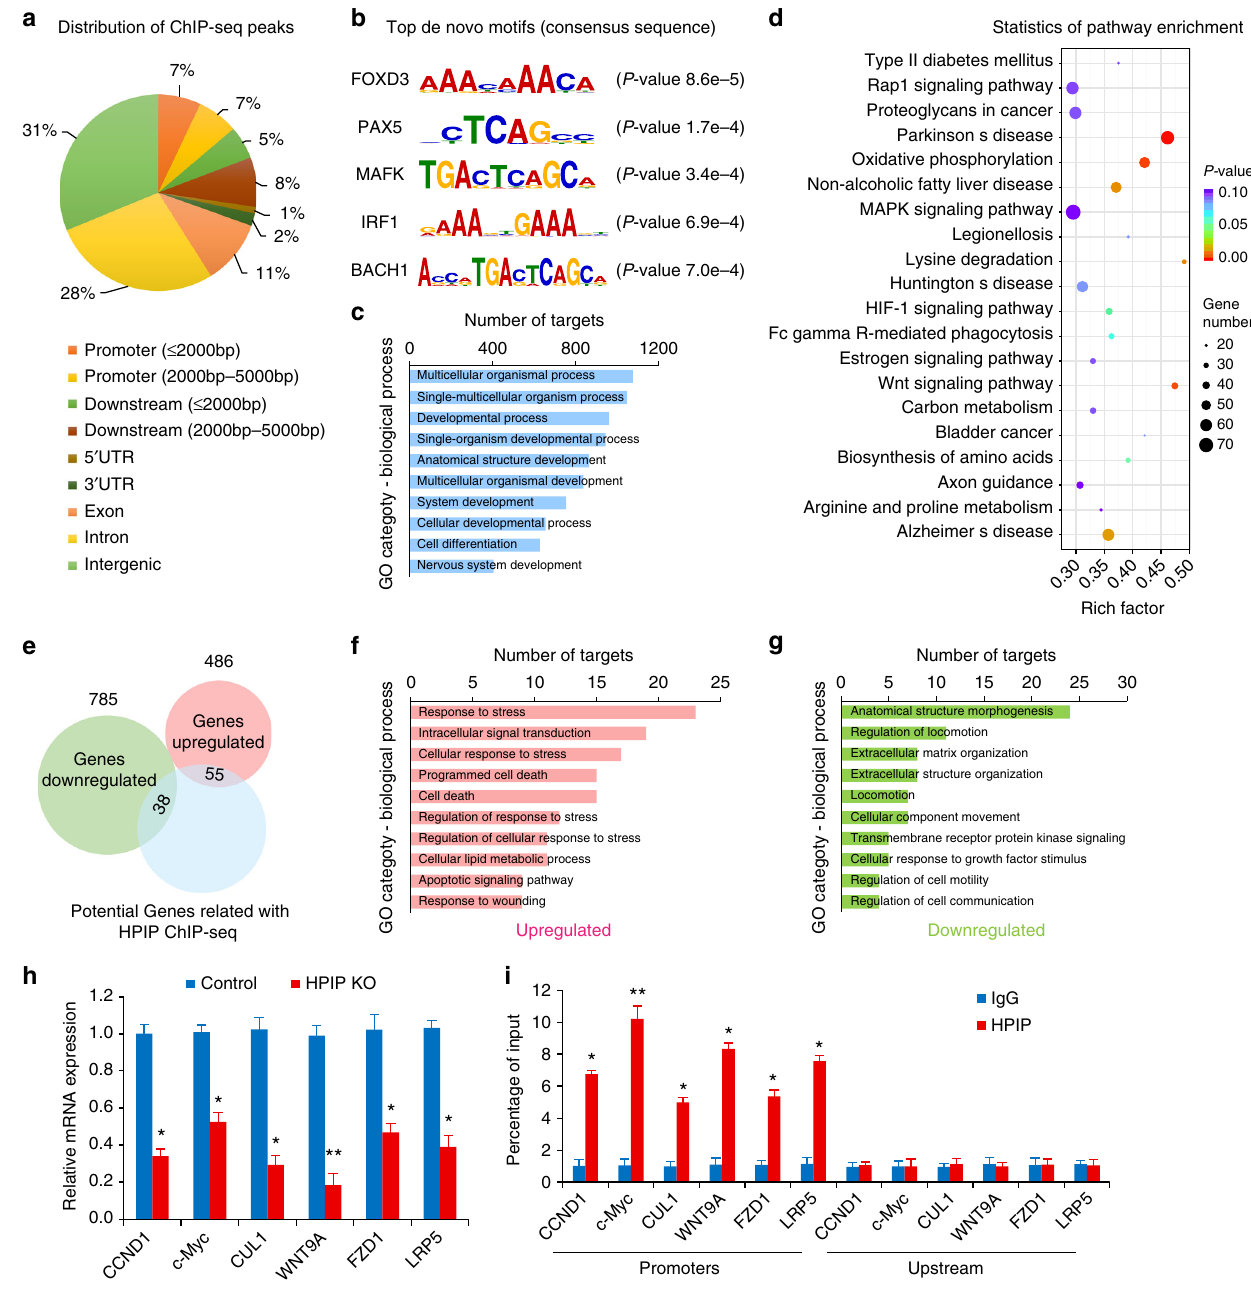
Fig. 5 Chromatin immunoprecipitation (ChIP) analysis of cartilage homeostasis-related genes regulated by HPIP . a HPIP -binding regions are mapped by ChIP-seq. The annotation shows that a peak is in the promoter (de fi ned as ≤ 2000 bp), the promoter (de fi ned as 2000 – 5000bp), downstream of the promoter (de fi ned as ≤ 2000 bp), downstream of the promoter (de fi ned as 2000 – 5000bp), 5 ′ UTR, 3 ′ UTR, intron or intergenic. b Top de novo motifs enriched in the vicinity of the HPIP -binding sites. c GO functional clustering of targets associated with HPIP ChIP-seq peaks for biological process (top 10 most signi fi cantly affected categories are shown). d KEGG pathway enrichment analysis of targets associated with HPIP ChIP-seq peaks. e An overlay of RNA-seq and ChIP-seq analysis results revealed genes as potential direct targets of HPIP in chondrocytes. f , g Gene ontology (GO) functional clustering of genes that were upregulated and downregulated for identi fi cation of biological processes directly regulated by HPIP , respectively (top 10 categories most signi fi cantly affected are shown). h qRT-PCR validation analysis of the indicated genes in the control vs HPIP KO chondrocytes. i ChIP assay for HPIP occupancy on the CCND1 , c-Myc , CUL1 , WNT9A , FZD1 , and LRP5 promoters or upstream of the promoters in chondrocytes. Error bar represents the standard deviation (s.d.) and P- value was generated by using one-way ANOVA with Tukey ’ s post hoc test. * P < 0.05; ** P <